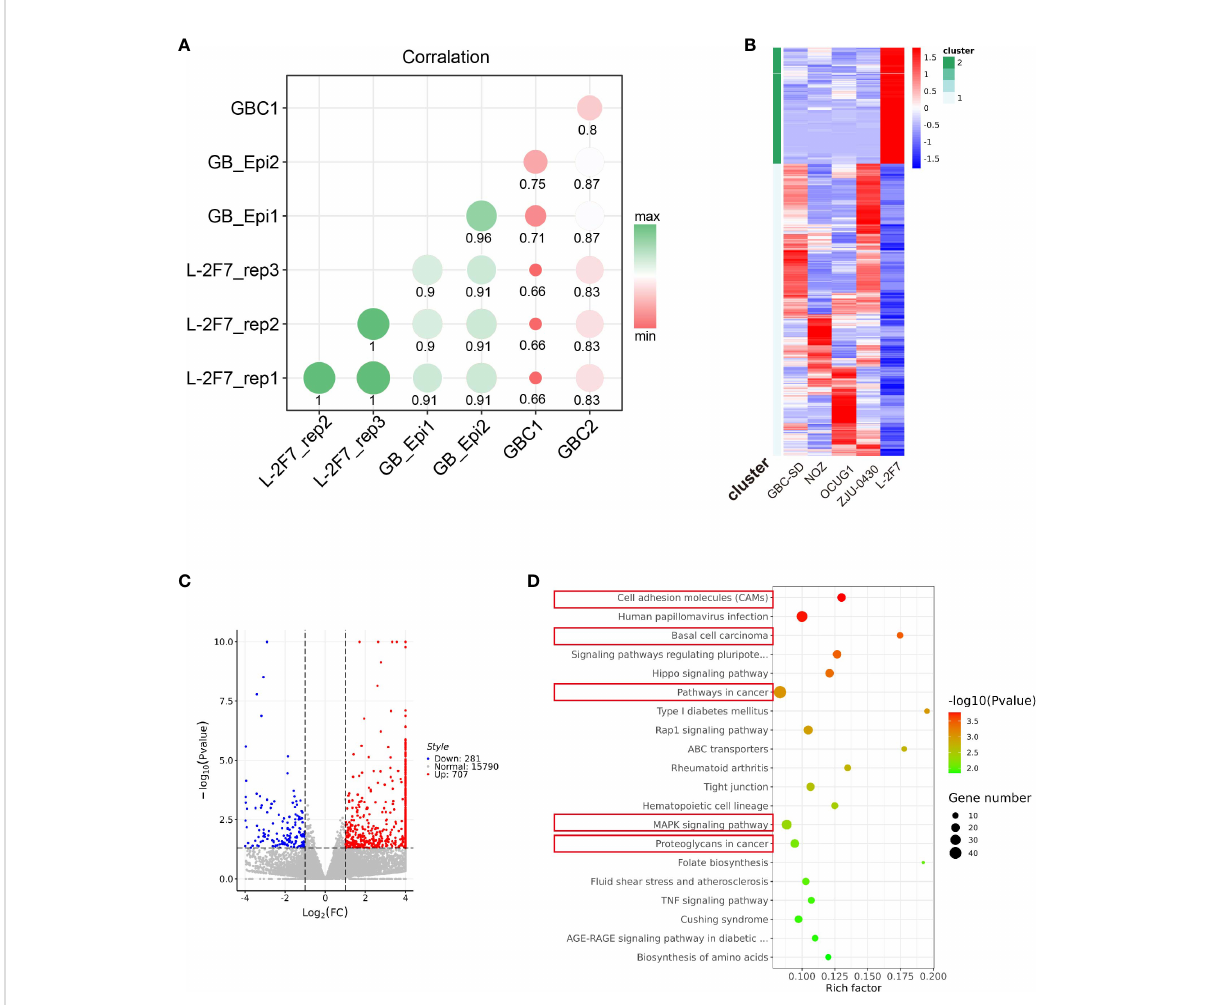
FIGURE 4 Transcriptome pattern of L-2F7 cells. Transcriptome sequencing was performed in L-2F7 cells, two normal gallbladder epithelium tissues, two gallbladder cancer tissue, and other gallbladder cancer cell lines including NOZ, GBC-SD, ZJU-0430, and OCUG1. The correlation mapping between L-2F7 and various gallbladder tissues was exhibited in the graph (A) . Differentially expressed genes were shown in the heatmap (B) and volcano plot (C) . Gene ontology analysis was performed by comparing L-2F7 and cancer cell lines, and cancer-related pathways were marked with red rectangles (D)